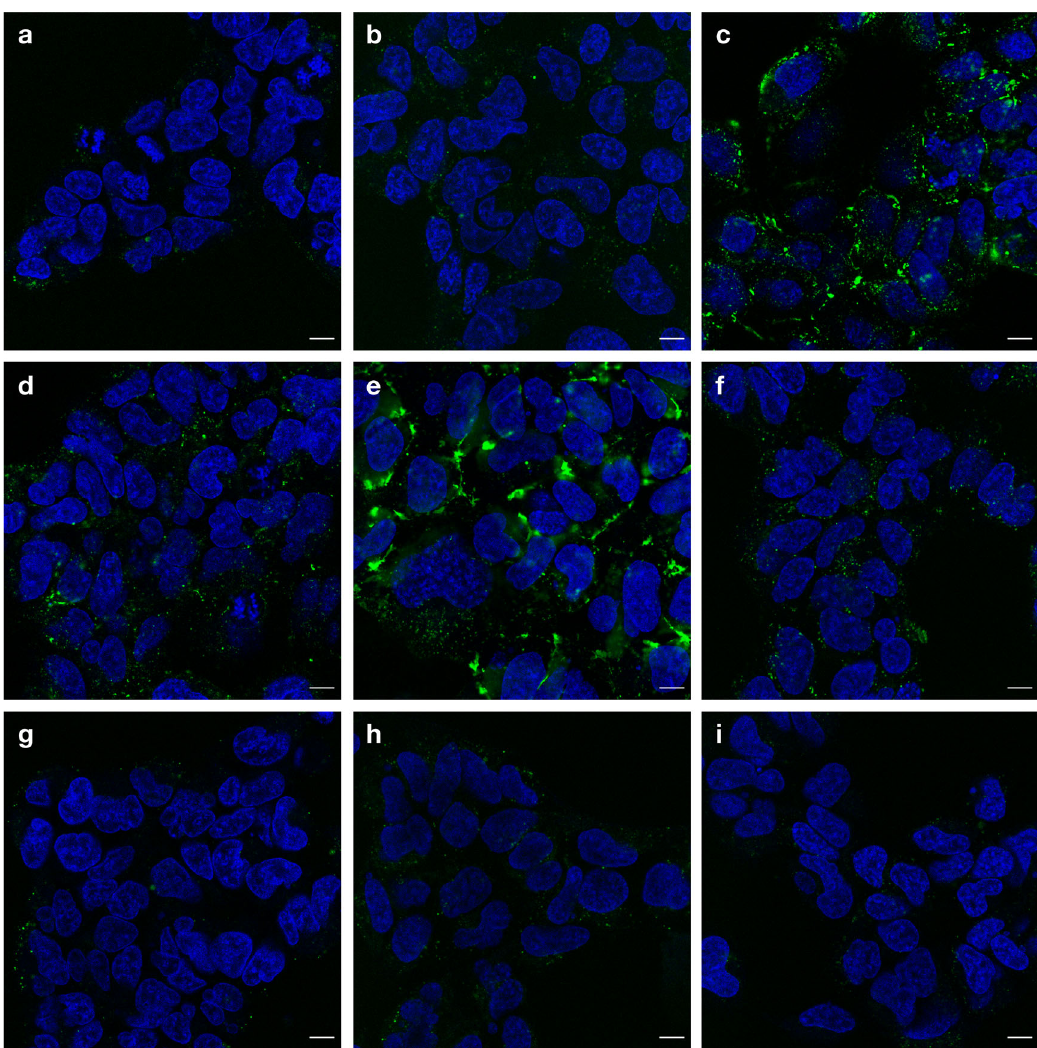
Fig. 5 EEP-GFP-HiBiT fusion proteins exhibit punctate staining, suggesting limited endosomal escape. HEK293-LSA cells treated with 1 µ M EEP-GFP- HiBiT (green) proteins: a GFP, b R9, c TAT, d ZF5.3, e E5TAT, f 5.3, g pHD118, h pHlip and i HA2 at 1 µ M for 4 h. Cells were washed and nuclei were stained with Hoechst 33342 (pseudocoloured blue) before confocal microscopy. n = 2 independent experiments Scale bar = 10 µ